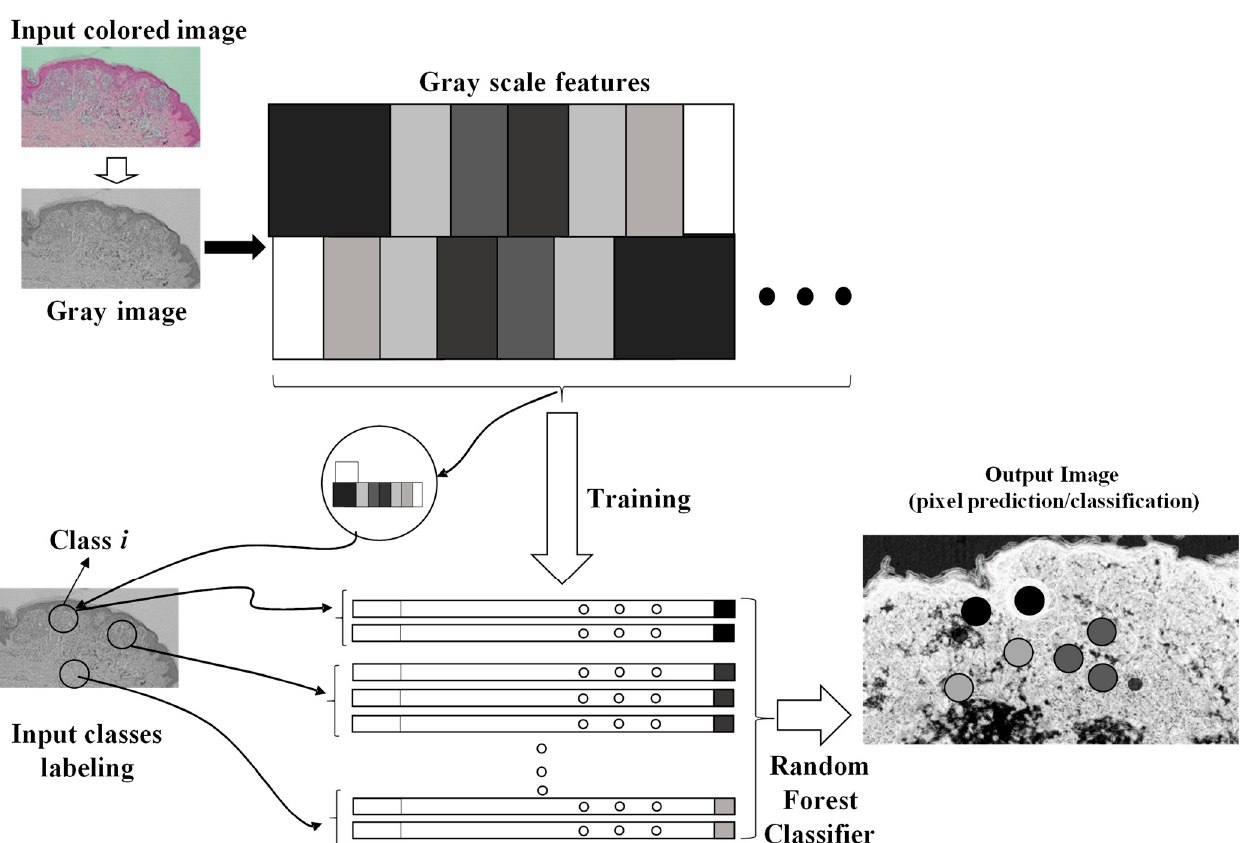
Figure 1. Image processing procedure based on pixel feature training and random forest classifier.